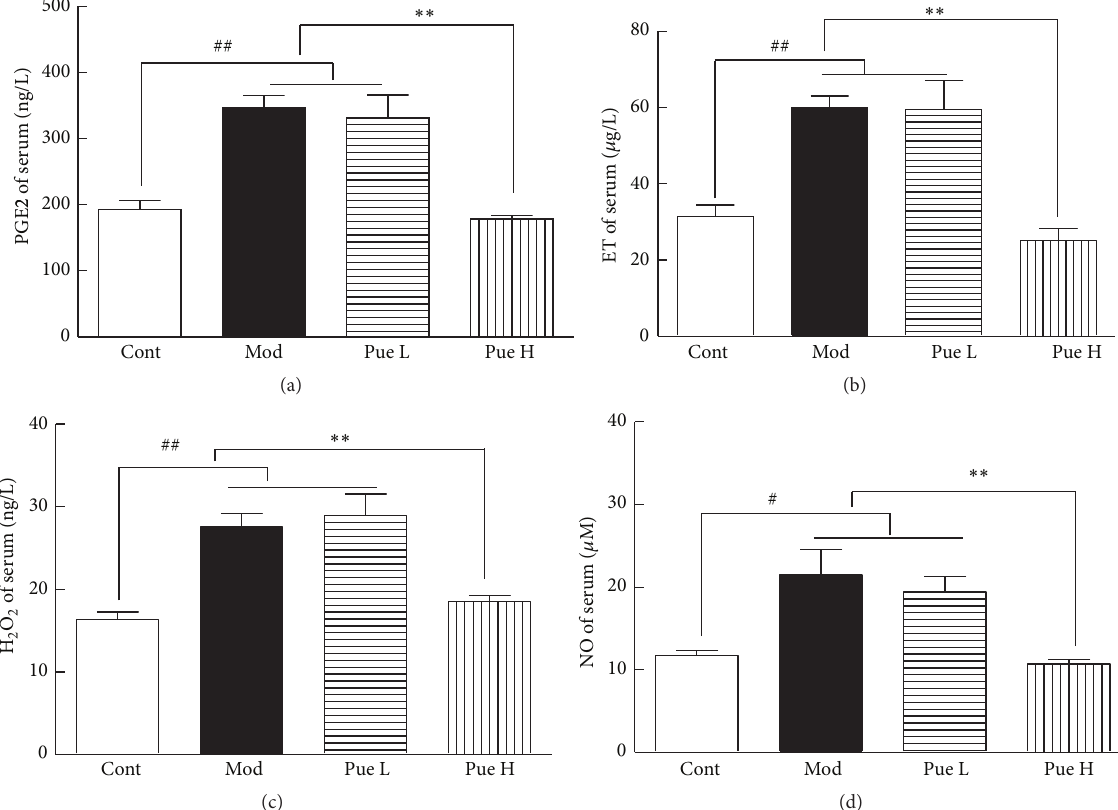
Figure2:EffectofpuerarinonserumPGE2(a),ET(b),H 2 O 2 (c),andNO(d)inSTZ-induceddiabeticrats. ## 𝑝 < 0.01 versusCont; ∗∗ 𝑝 <